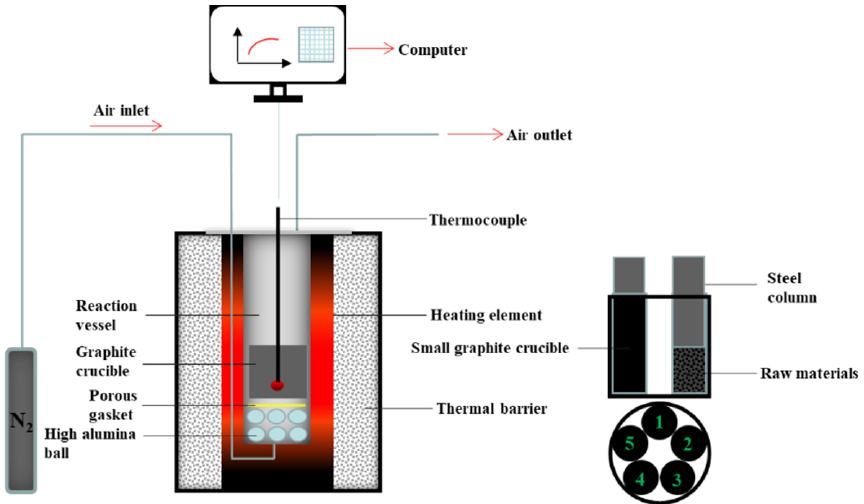
Figure 3. The diagram of self-developed vertical tubular furnace.